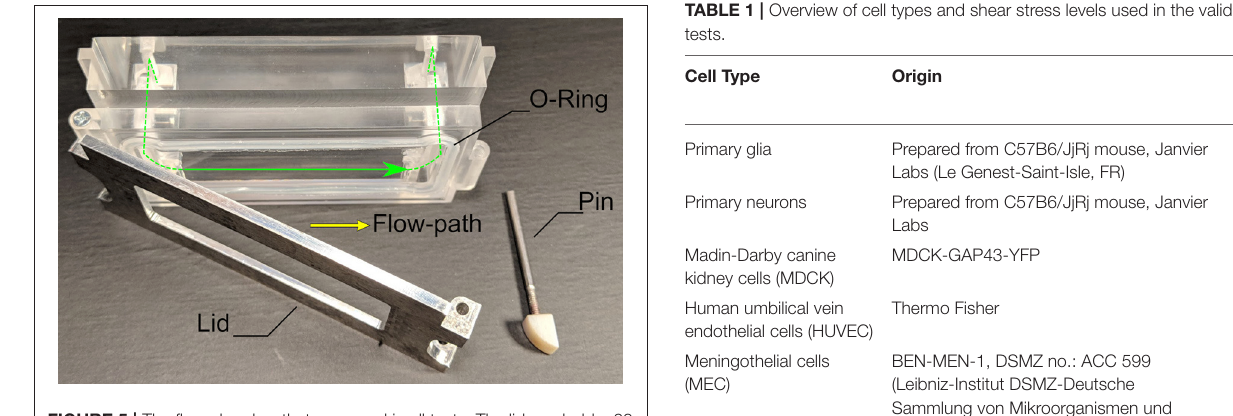
FIGURE 5 | The flow chamber that was used in all tests. The lid can hold a 38 × 76 mm 2 glass slide of 1mm thickness on which the cells are attached. Closing the lid with the pin creates a rectangular flow-channel of 0.3 × 20 mm 2 cross-section, sealed off by the silicone O-ring.